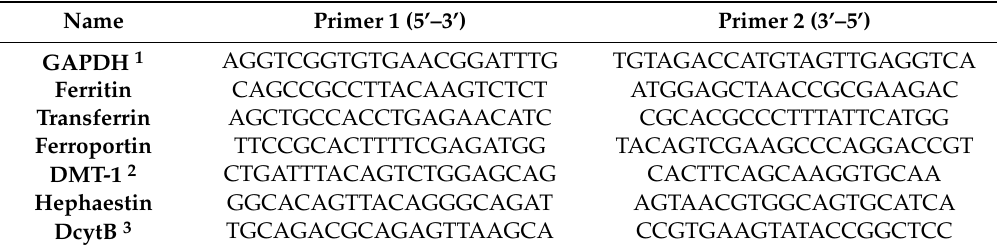
Table 2. Primers Used in Real-Time